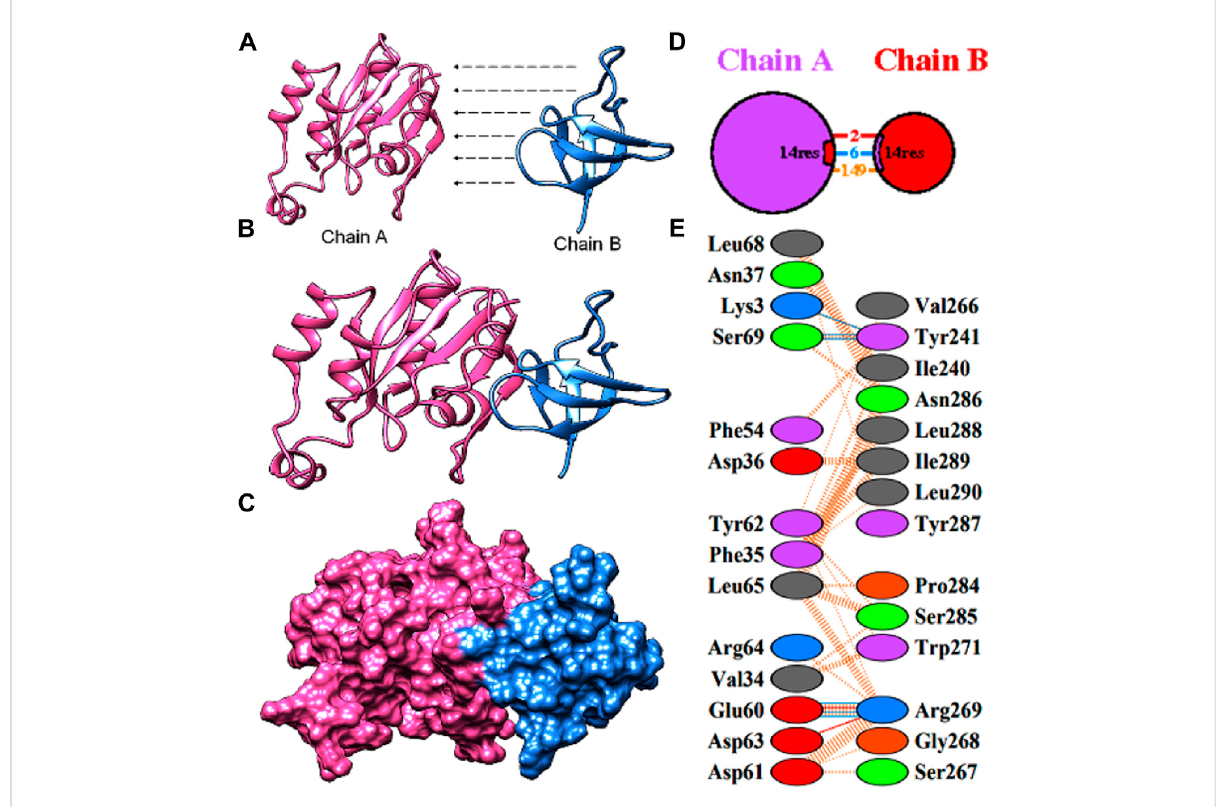
FIGURE 6 Protein-protein docking of the CDC42 with SHO1 from C. gloeosporioides (A) model proteins of CDC42 (pink) and SHO1 (blue). (B) and (C) interactionofthemodelproteins (D) pictorialrepresentationoftheinteractionmodelandnumberofinteractions (E)